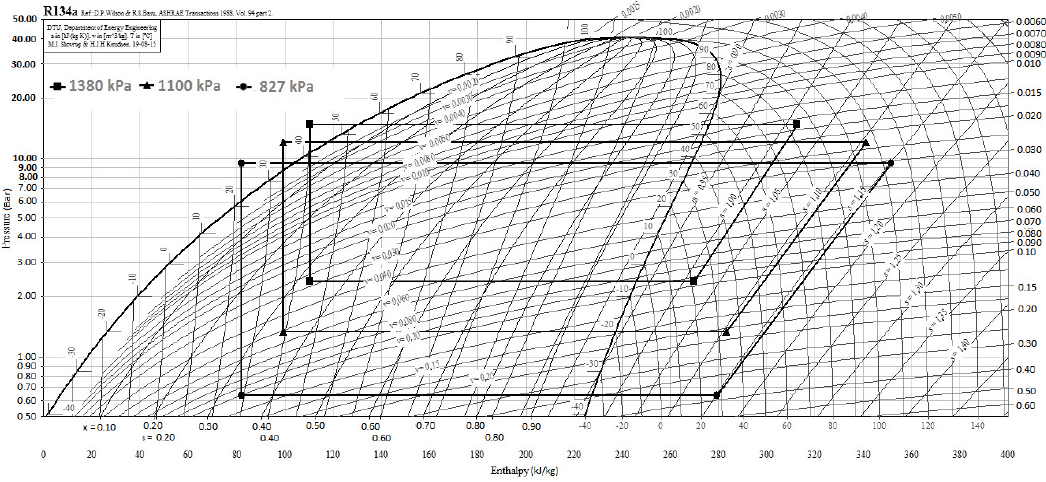
Figure 9. P-h diagram for the drying heat pump.